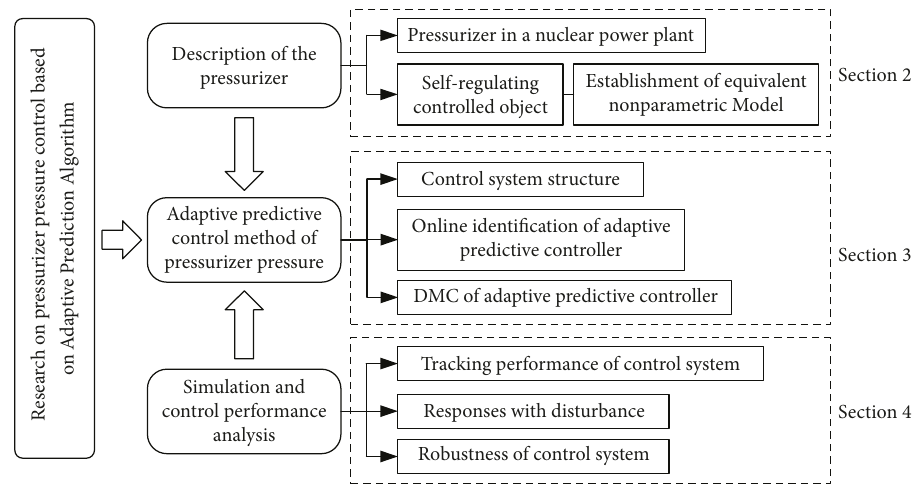
Figure 1: Article structure